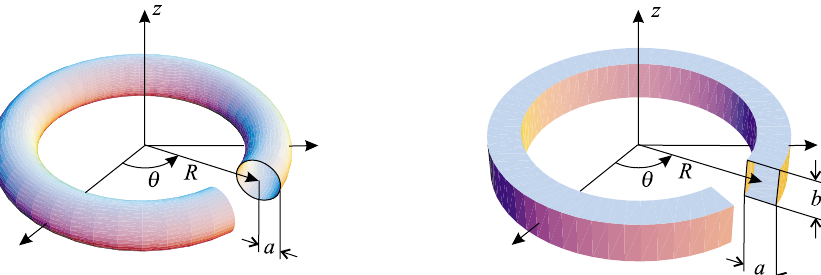
FIG. 1. (Color) Smooth toroidal vacuum camera for circular (left) and rectangular (right) cross sections with R the major radius of the toroid. It is assumed that a particle’s orbit goes through the center of the toroidal chamber and has the same radius R . A segment is removed for illustration